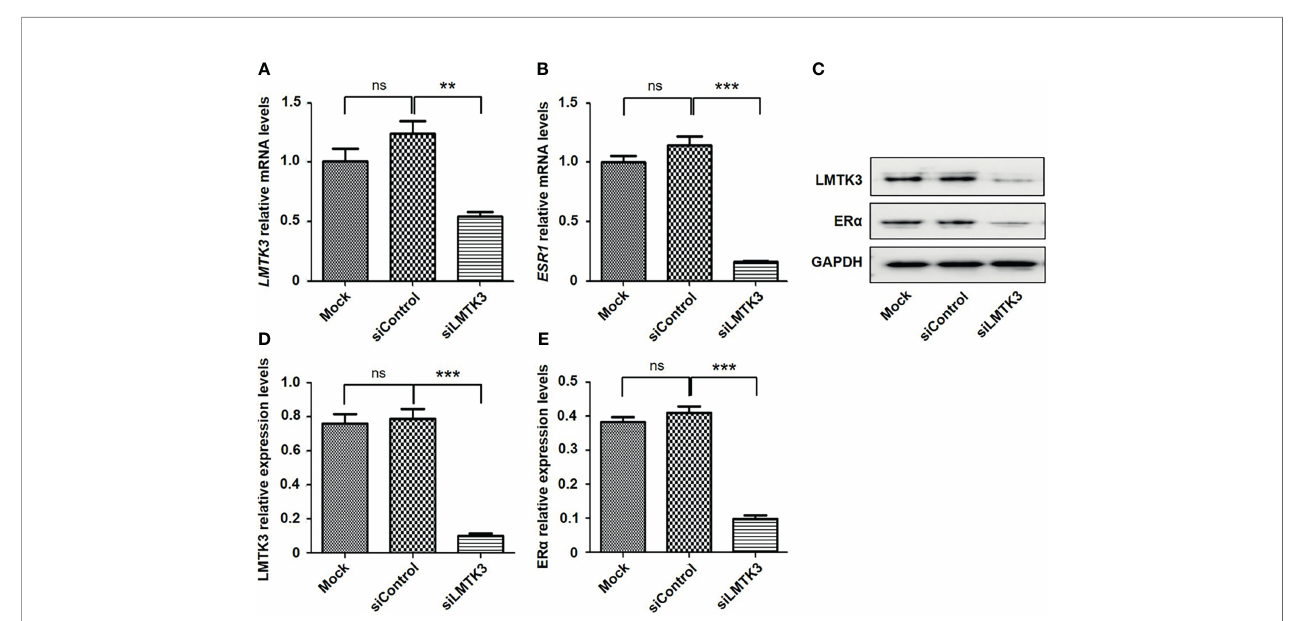
FIGURE 6 | Knockdown of LMTK3 reduces the mRNA and protein levels of ER a . (A, B) Effects of LMTK3 knockdown on the mRNA level of ER a (n=3, ** P < 0.01, *** P < 0.001), ns represents no statistical signi fi cance). (C) Representative image of LMTK3 knockdown on the protein level of ER a . (D, E) Effects of LMTK3 knockdown on the protein level of ER a (n=3, *** P < 0.001). siControl represents nontargeting siRNA. Mock represents nontreatment. ns represents no statistical signi fi